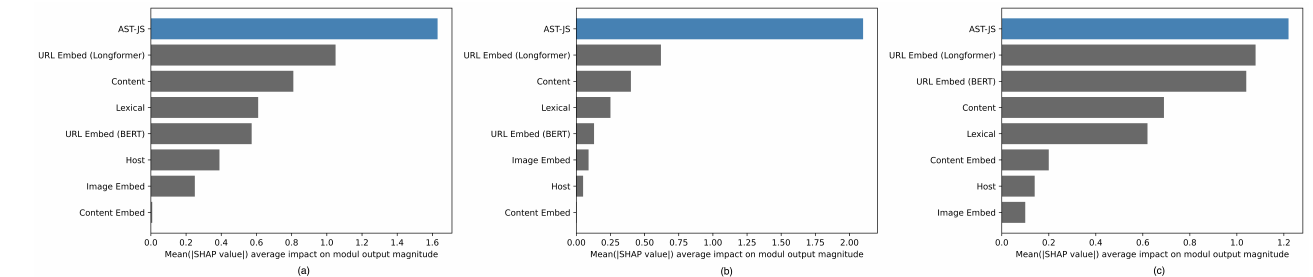
Figure 10. Total average SHAP values for (a) cluster 0, (b) cluster 1, and (c) cluster 2.